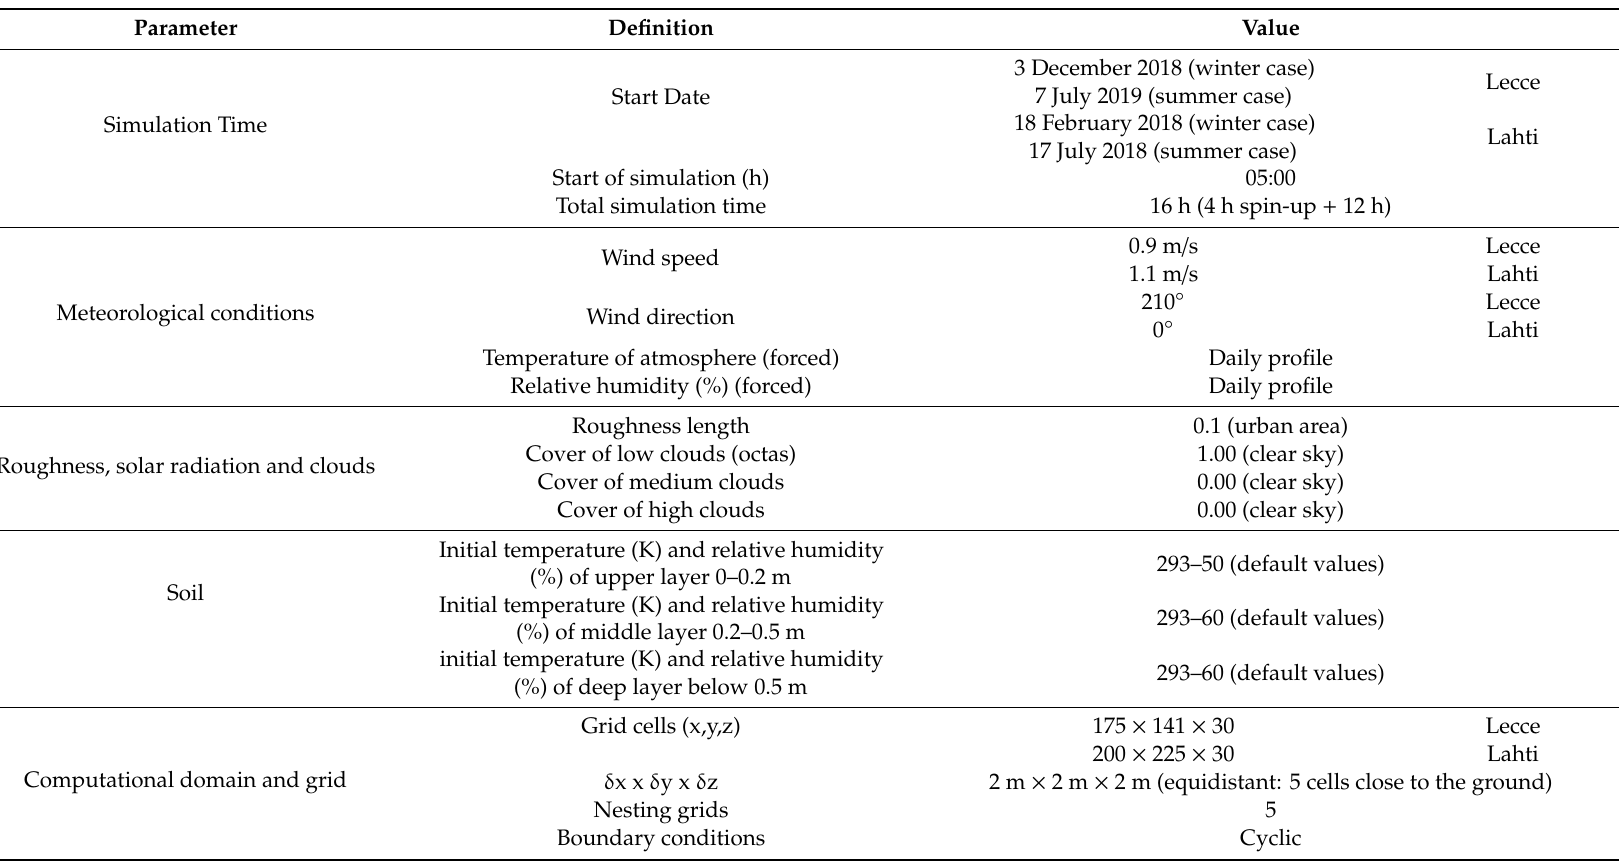
Table 2. Initial and boundary conditions used in ENVI-met